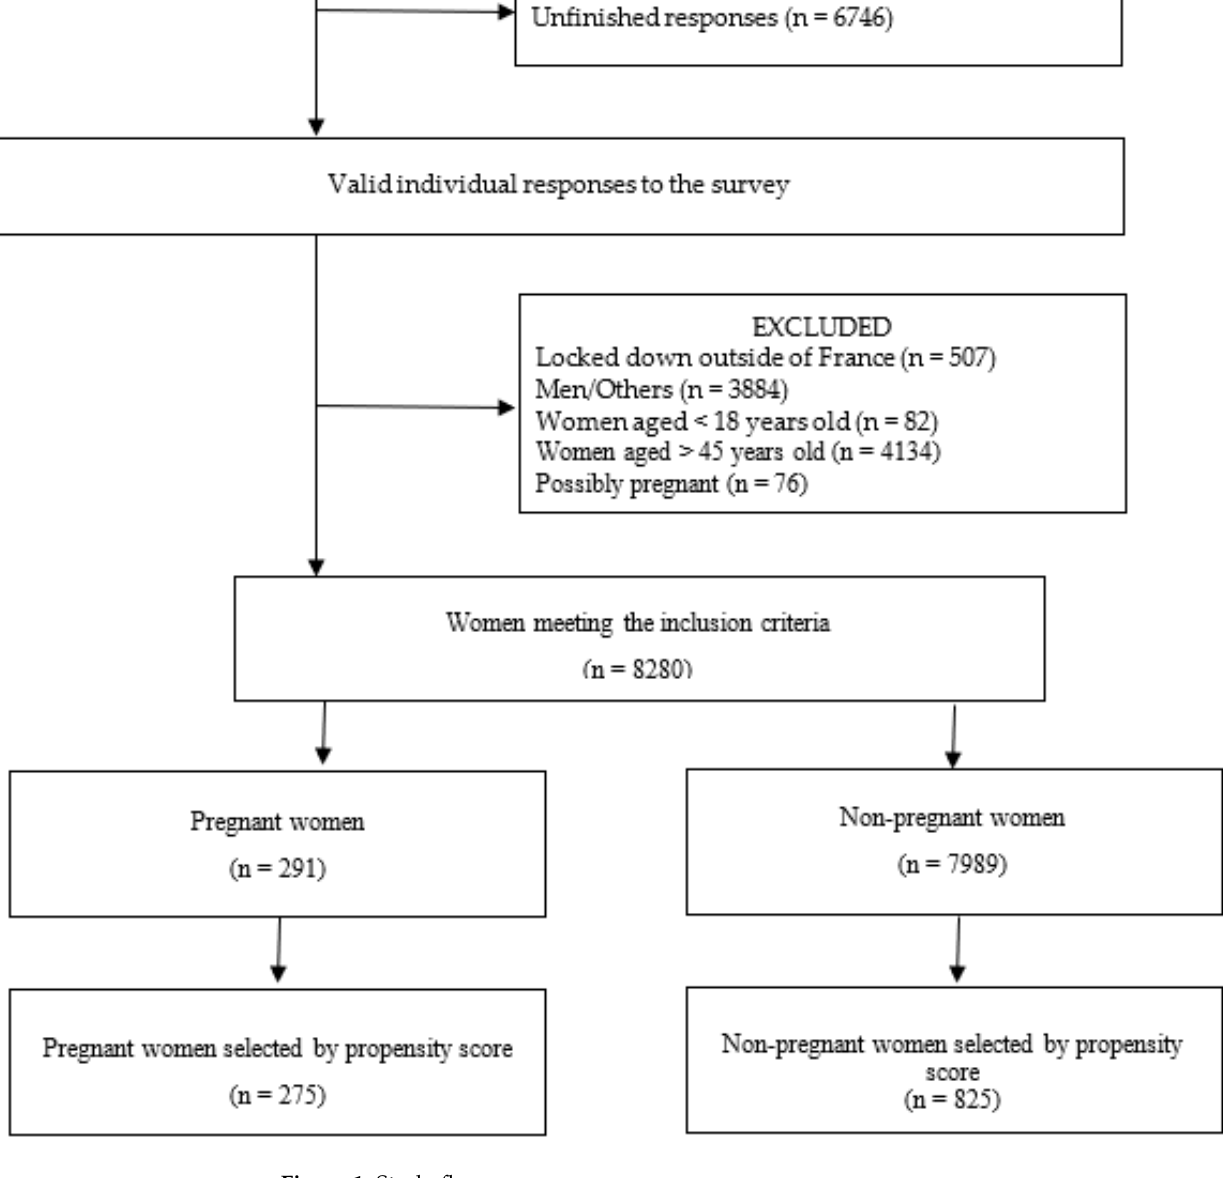
Figure 1. Study flow. Among pregnant women, suburban living was significantly associated with a lower level of well-being (47 vs. 50 for urban living). Sleep disorders were similarly significantly associated with poorer well-being (45.5 WEMBWS median), as was watching the news for more than an hour a day (47 WEMBWS median; Table 2). Pregnant women who were in relationships, or had a high level of education, or who worked alternately at home and at the office, tended to report higher levels of mental well-being, although these differences were not statistically